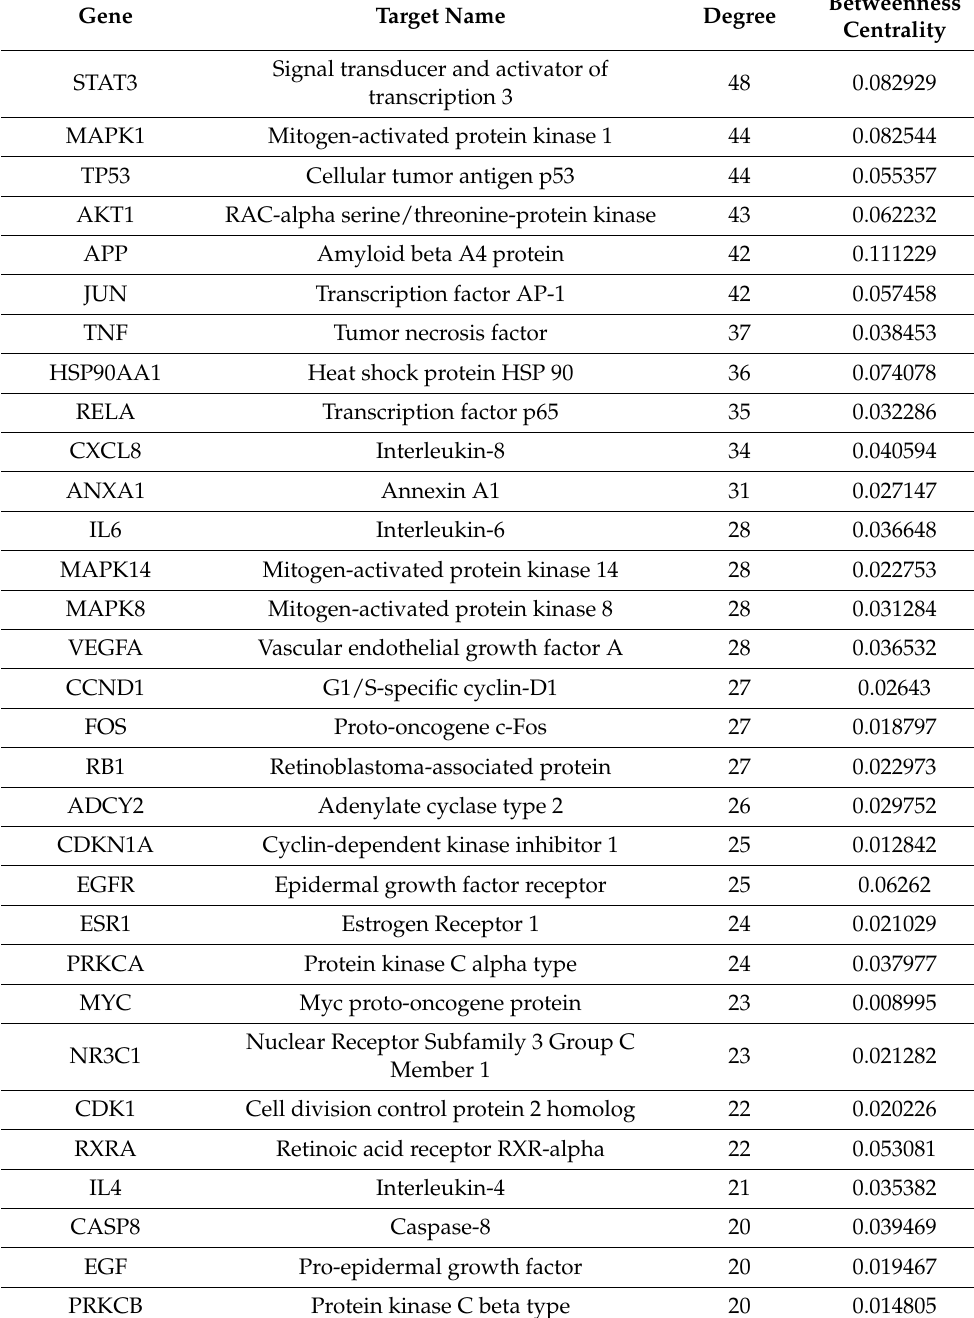
Table 2. Degree and betweenness centrality of the 47 key target genes targeted by SCH compounds as predicted by the PPI network structure.